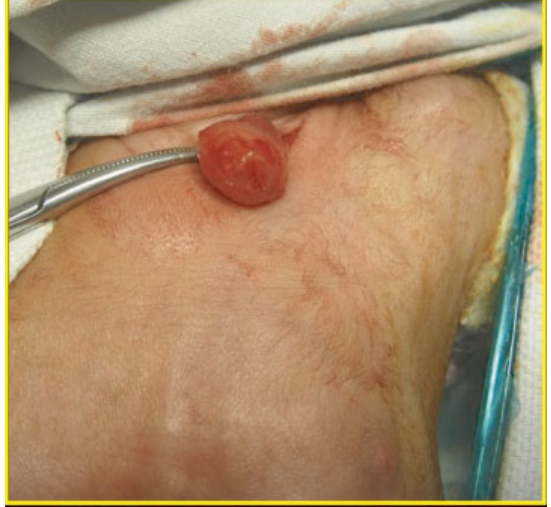
Fig. 2 Intraoperative photograph showing perforation at the tip of upper pouch. European Journal of Pediatric Surgery Reports Vol. 1 No.